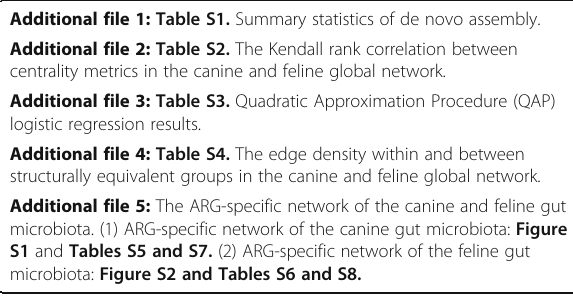
Additional file 1: Table S1. Summary statistics of de novo assembly.